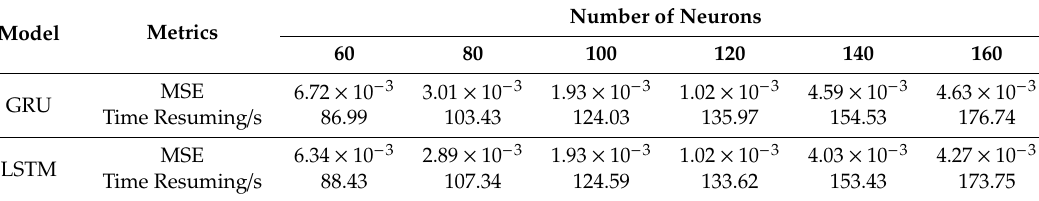
Table 3. Comparison of the experimental influence of di ff erent parameters of neurons on the two